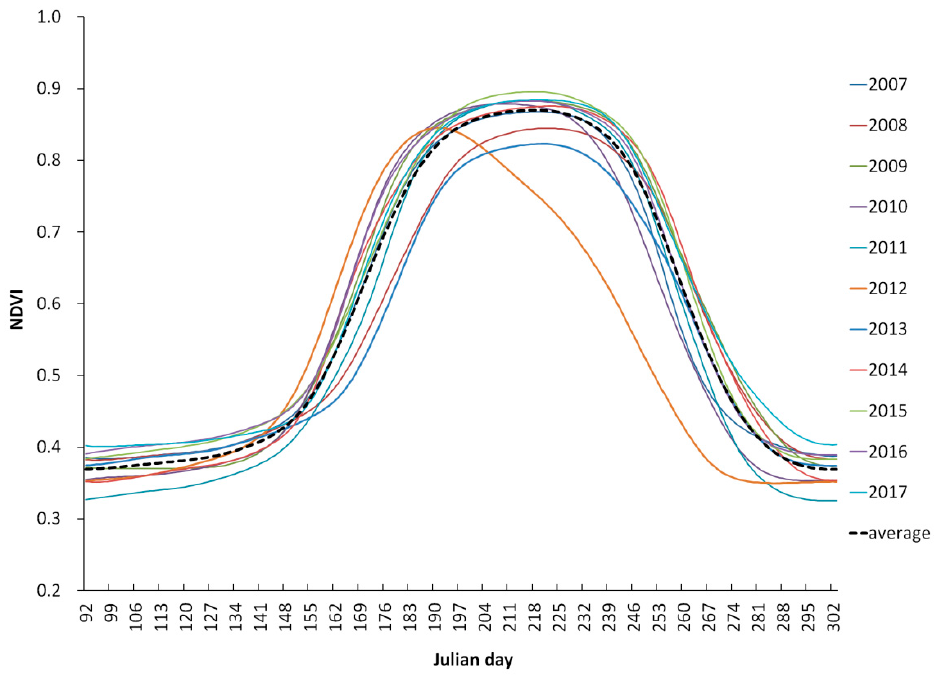
Figure 4. The corn phenologies in Carroll County from 2007 to 2017 and the NDVI baseline (dashed line). The corn phenology of the year 2012 (orange line) is abnormal and excluded from NDVI baseline calculation. The 2017 NDVI is the study target and its NDVI is not in the baseline